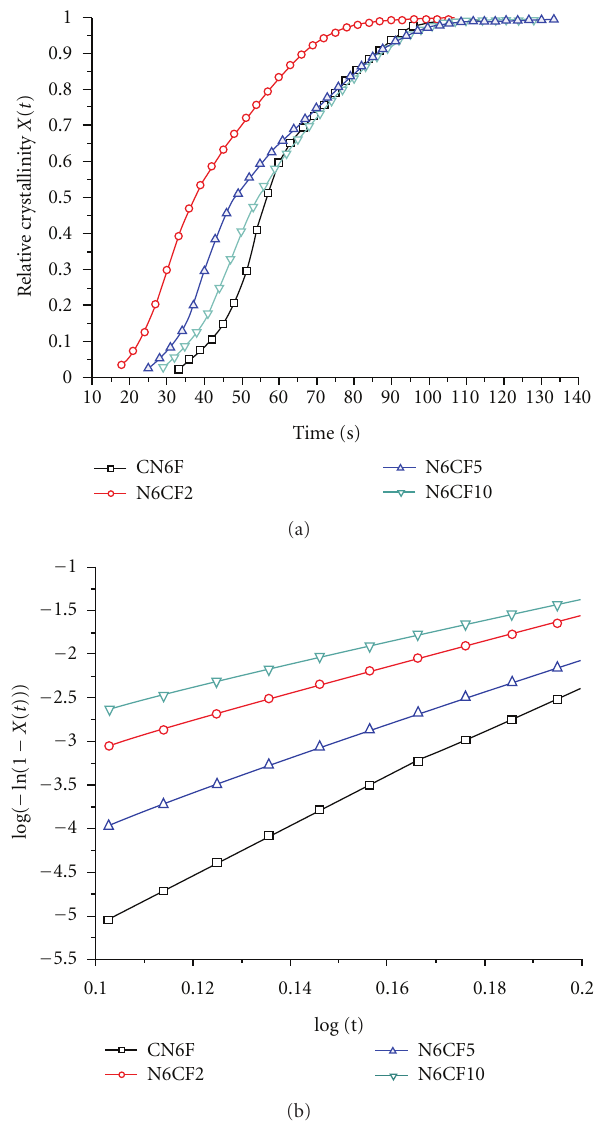
Figure 7: (a) Relative crystallinity for film samples, (b) Avrami plots log[ − ln(1 − X ( t ))] versus log( t ) for di ff erent film samples (color figure can be viewed in the online issue).